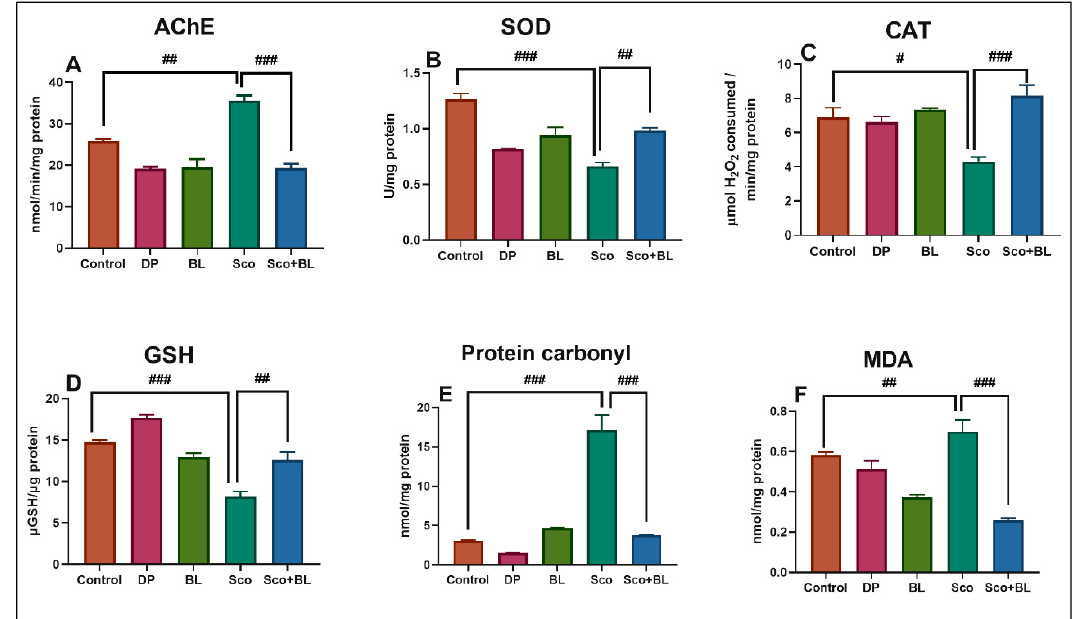
Figure 5. Effects of the bay leaf incense (BL) on ( A ) AChE; ( B ) superoxide dismutase (SOD); ( C ) glutathione peroxidase (GPX) specific activities; ( D ) reduced glutathione (GSH); ( E ) protein carbonyl and ( F ) malondialdehyde (MDA) level. Values represent means ± S.E.M. ( n = 5) followed by Tukey’s post hoc analyses: ( A ) Control vs. Sco: ## p < 0.001, Sco vs. Sco + BL: ### p < 0.0001; ( B ) Control vs. Sco: ### p < 0.0001, Sco vs. Sco + BL: ## p < 0.001; ( C ) Control vs. Sco: # p < 0.01, Sco vs. Sco + BL: ### p < 0.0001; ( D ) Control vs. Sco: ### p < 0.0001, Sco vs. Sco + BL: ## p < 0.001; ( E ) Control vs. Sco: ### p < 0.0001, Sco vs. Sco + BL: ### p < 0.0001; ( F ) Control vs. Sco: ## p < 0.001, Sco vs. Sco + BL: ### p < 0.0001.